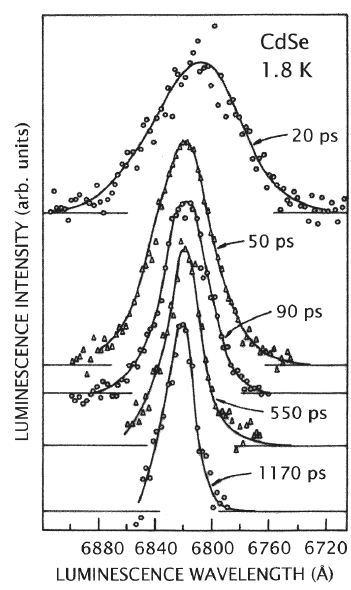
Figure 13. Photoluminescence spectra of CdSe platelets under high levels of excitation, obtained at the indicated delay times after pulse excitation. (Daly 81